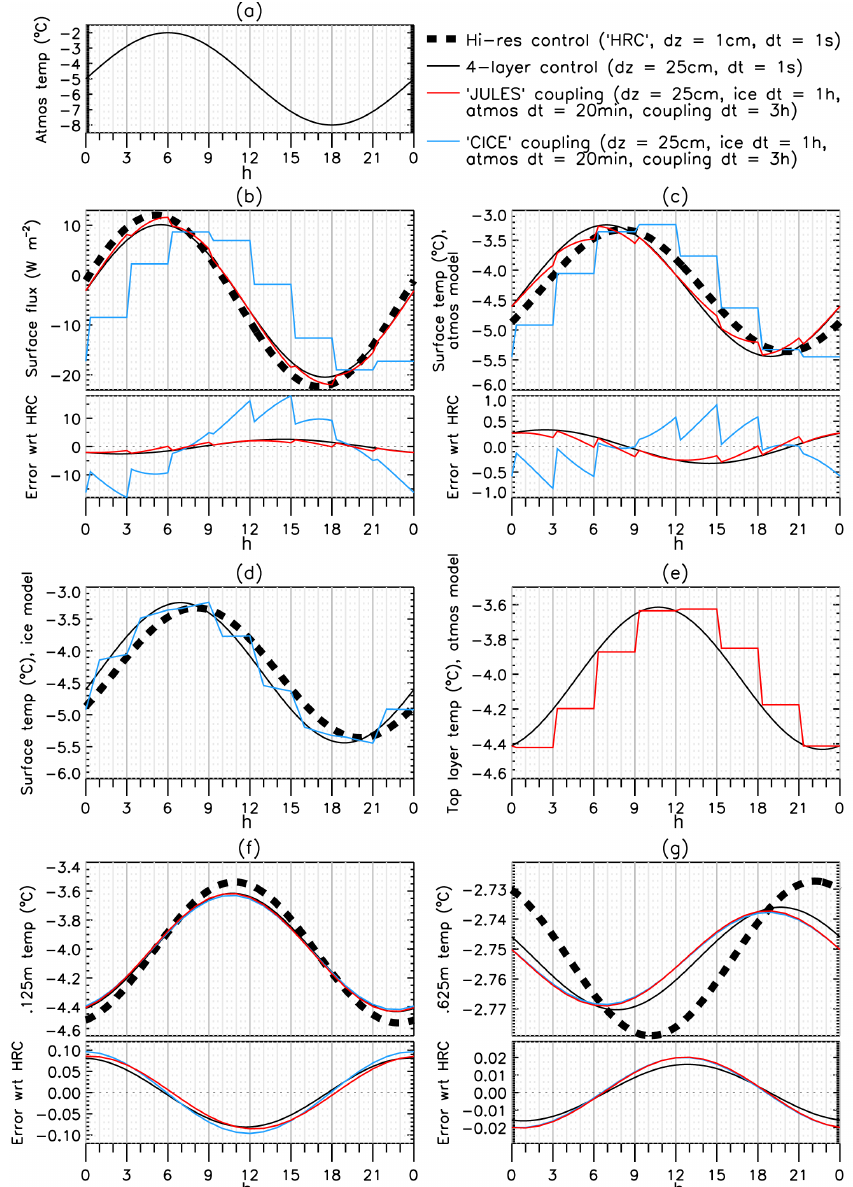
Figure 5. Comparing the two coupling methods, with a 3h coupling period. Showing (a) atmospheric air temperature (the experiment forcing); (b) surface flux; (c) surface temperature, as seen by the atmosphere; (d) surface temperature as seen by the ice; (e) 0.125m ice temperature as seen by the atmosphere; (f) 0.125m temperature as seen by the ice; (g) 0.625m